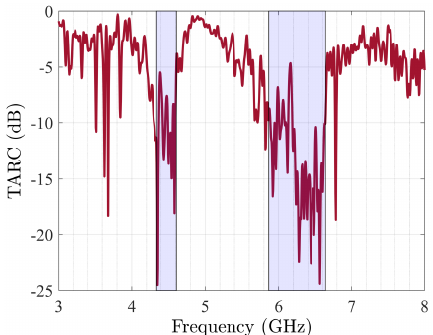
Figure 5. TARC of optimized implanted MIMO